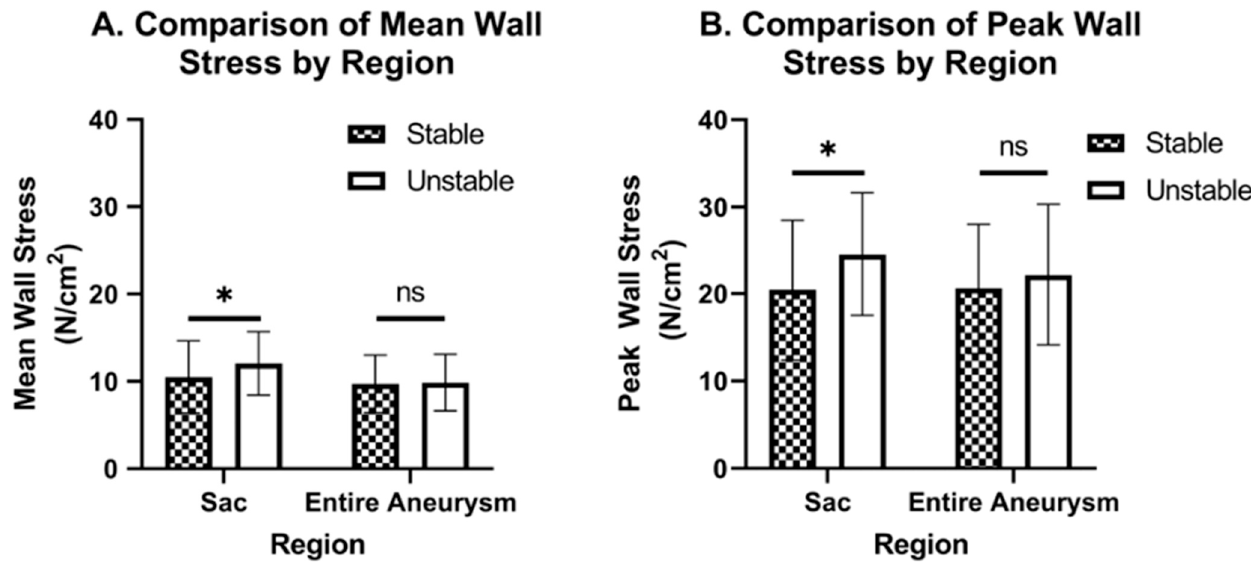
Figure 4. Comparison of MWS ( A ) and PWS ( B ) in sac and entire aneurysm regions, shows significant differences in stable versus unstable cases for the sac-isolated region but not for the entire aneurysm. The * symbol denotes a statistical difference ( p < 0.05) and not significant is abbreviated as ‘ns’.